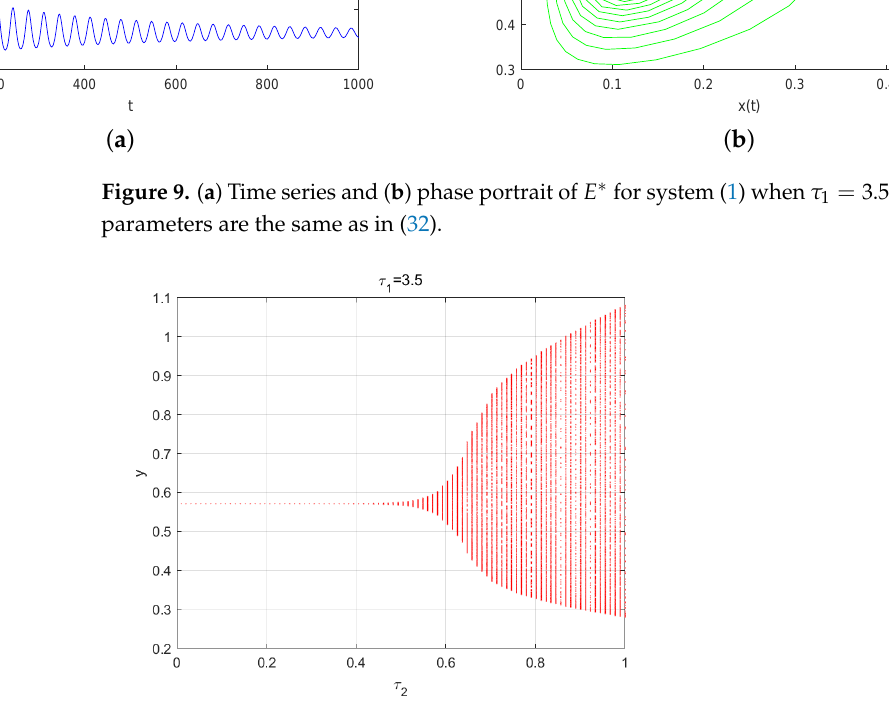
Figure 10. The Hopf bifurcation diagram of (1) for τ 2 and τ 1 =